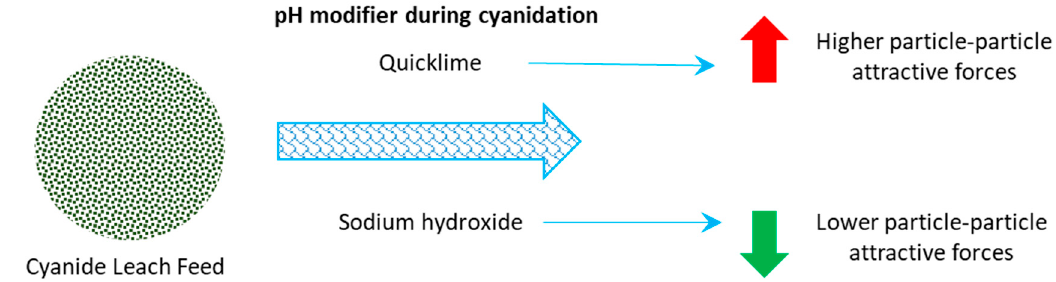
Figure 5. Illustration of the effect of pH modifier type on the particle-particle interaction during cyanidation.